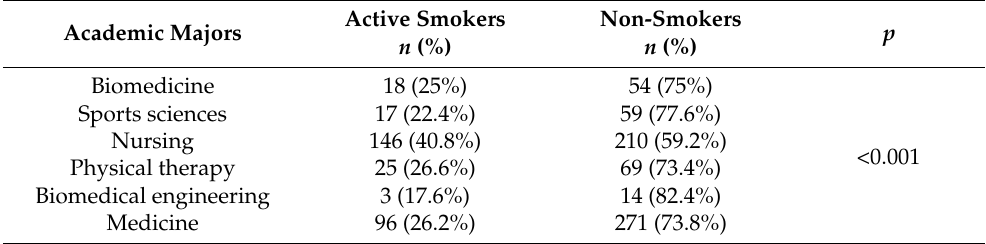
Table 5. Distribution of smokers and non-smokers among academic majors ( n = 982).